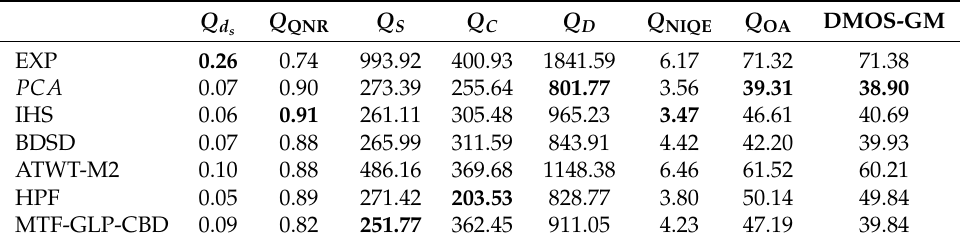
Table 10. IKONOS Roma Urban scene, full-resolution, image quality assessment metrics, and DMOS GM quantitative results. The bold number indicates the best performing PS method according to each quality metric.